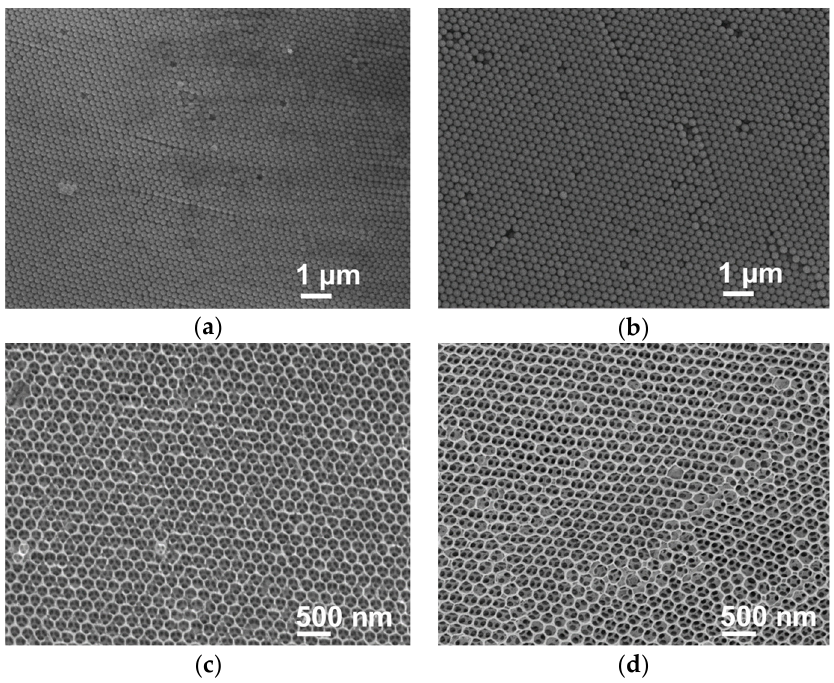
Figure 2. SEM images of opal polystyrene (PS) and inverse opal (IO) titania structures: ( a , b ) PS opal with: ( a ) 200-nm and ( b ) 250-nm sphere sizes, and ( c , d ) replicated titania IO films with: ( c ) 180-nm and ( d ) 207-nm voids; adapted with permission from [78]. Copyright 2018 Creative Commons Attribution.